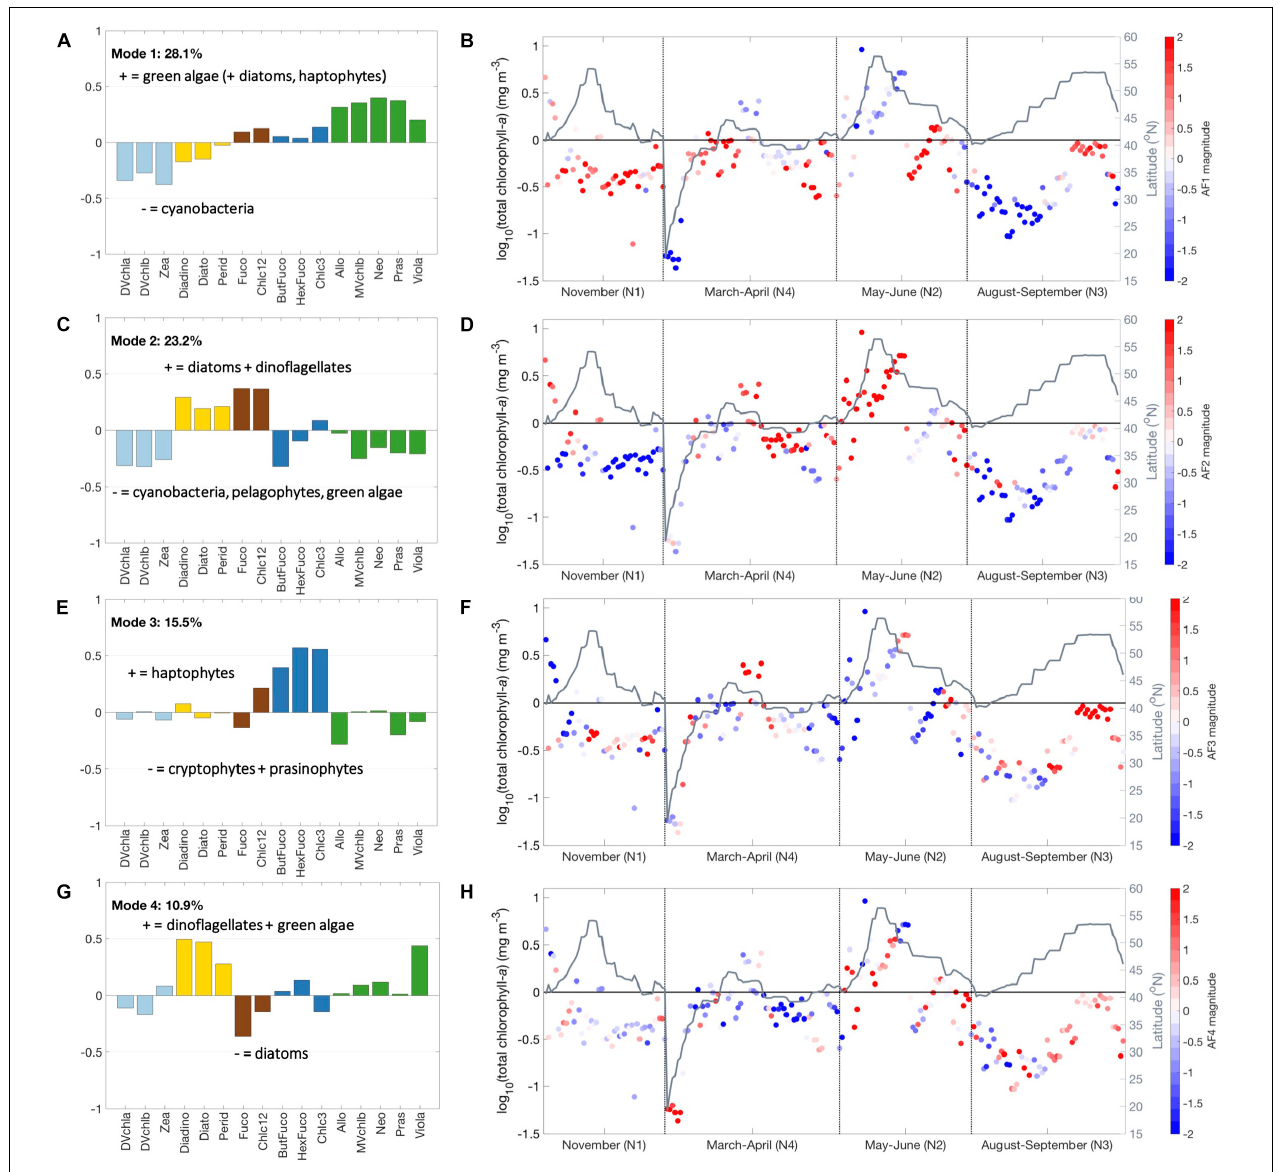
FIGURE 4 | Empirical orthogonal functions for Mode 1 (A,B) , 2 (C,D) , 3 (E,F) , and 4 (G,H) , calculated for phytoplankton pigment ratios to total chlorophyll- a concentration. Loadings are colored based on pigment clusters ( Figure 3 ): light blue (cyanobacteria), dark blue (haptophytes), green (green algae), brown (diatoms), and gold (dinoflagellates). Amplitude function magnitude is indicated as positive (red) or negative (blue) for each sample and latitude is in